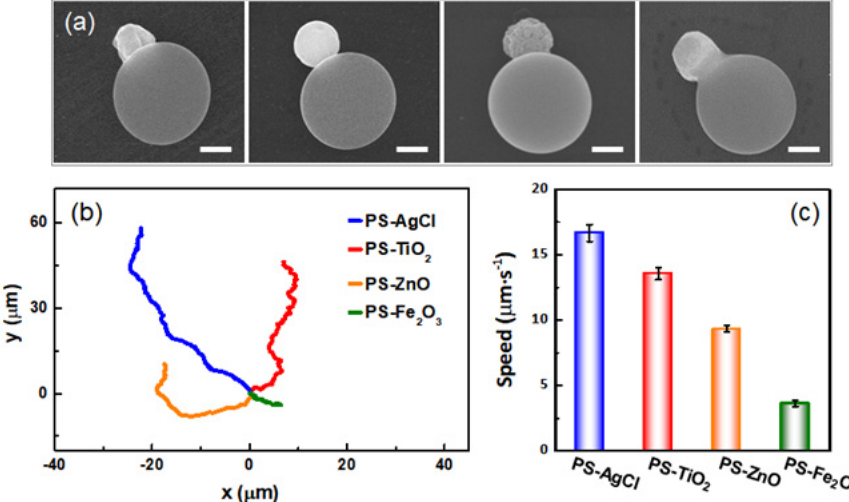
Figure 4. ( a ) SEM images of different hybrid dimer active colloids. The small inorganic particles embedded into the large PS particles are AgCl, TiO 2 , ZnO, and Fe 2 O 3 (left to right). Scale bars: 500 nm. ( b ) The corresponding trajectories of the active colloids in 5 s under UV illumination and in 1% ( v / v ) H 2 O 2 solution. The starting points of the trajectories are shifted to the origin for clarity. ( c ) Average speeds of different active colloids. The error bars represent the standard deviations of 10 measurements.